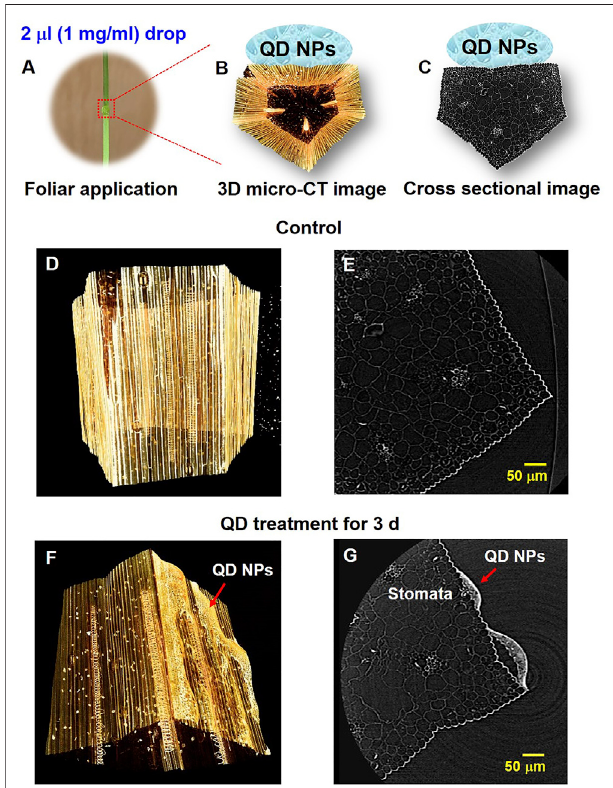
FIGURE2| AdsorptionofQDNPsontheabaxialsurfaceofagarlicchive leaf. (A) QDNPsuspension(2 µLdroplet)wasdepositedontheabaxialsideof the garlic chive leaf. 3D (B) and cross-sectional (C) images (10 × ) of the fi xed garlicchiveleafbasedonmicro-CT. (D,E) 3Dandcross-sectionalmicro- CT image (20 × ) of the control garlic chive leaf. (F,G) QD NP deposition and penetration through stomata. QD NPs translocated across the leaf epidermal barrier through the stomata. Red arrowheads indicate QD